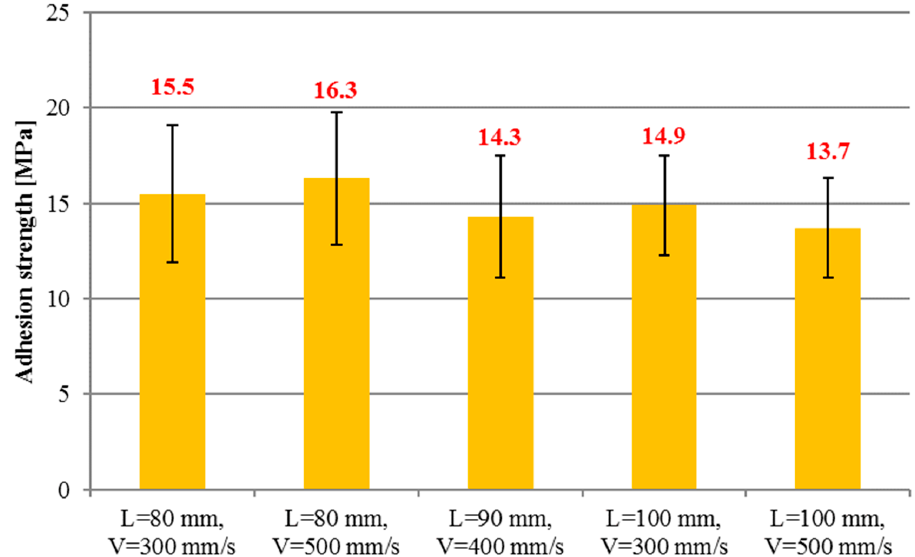
Figure 8. Adhesion strength of AT13 coatings.